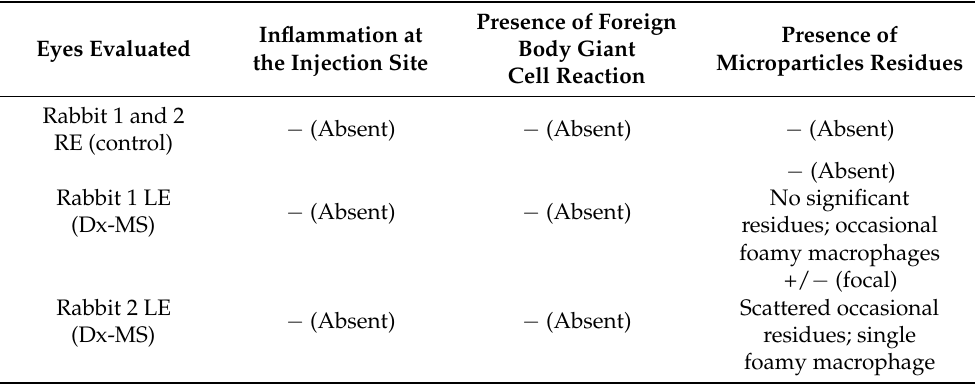
Table 6. Scored histopathological evaluation at 42 days after sub-Tenon injection of Dx-microspheres in PBS (left eye, LE) and control eye (right eye,